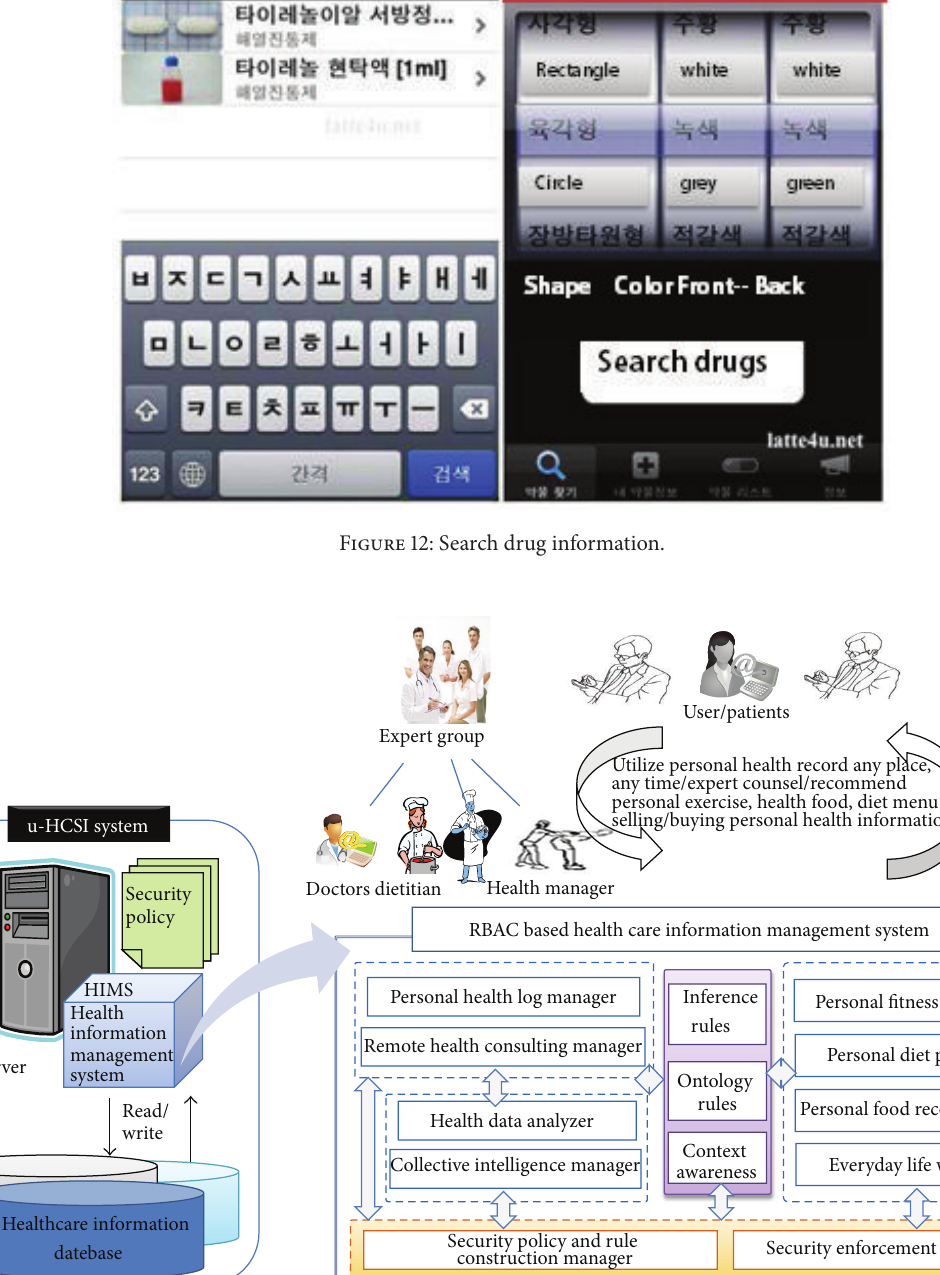
Figure 13: The software architecture of HIMS in